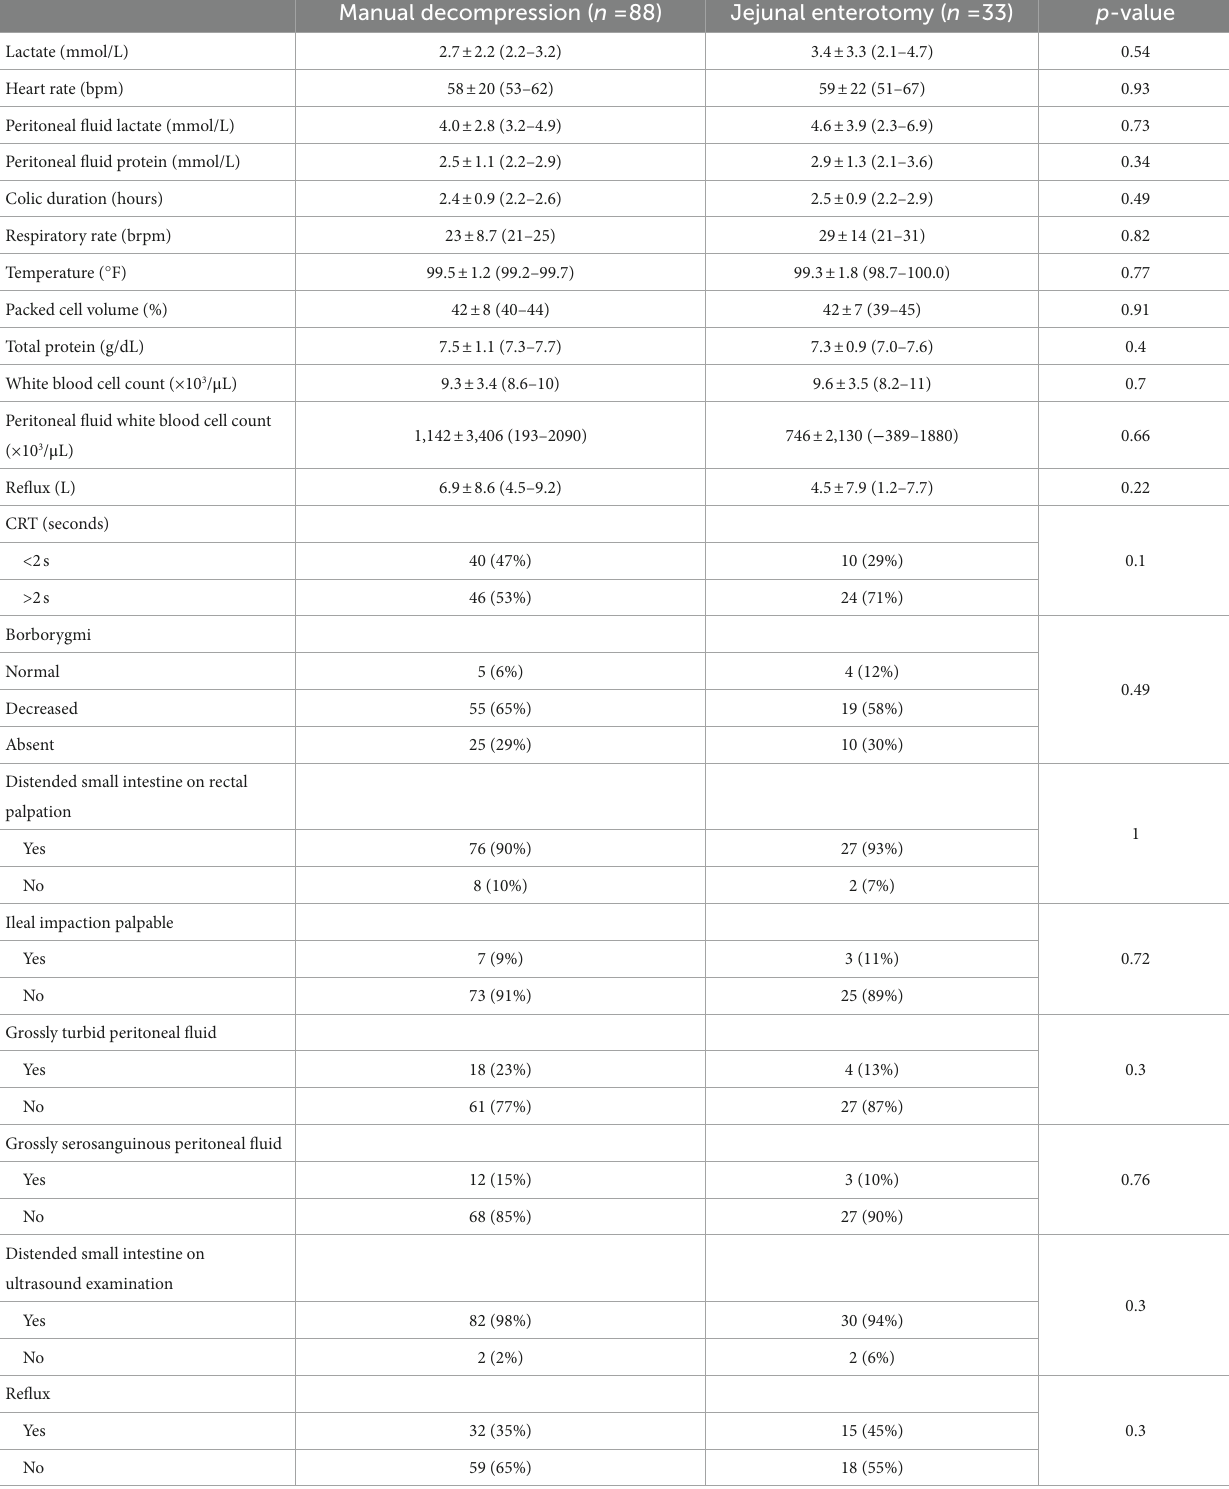
TABLE 1 Results of univariable analysis of pre-operative variables between decompression and enterotomy groups. Manual decompression ( n =